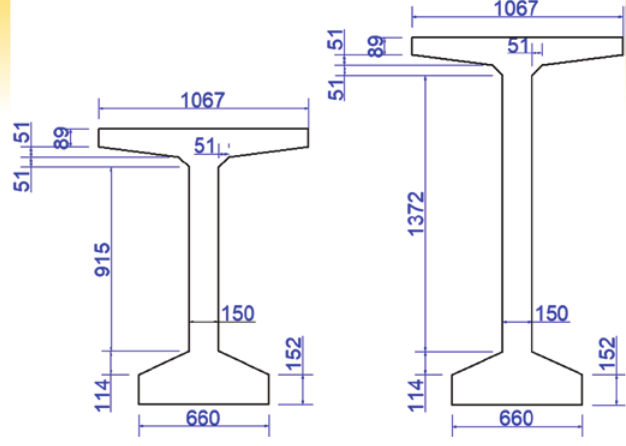
Figure 14 Beam sections BT-54 (left) and BT-72 (right) – dimensions in mm